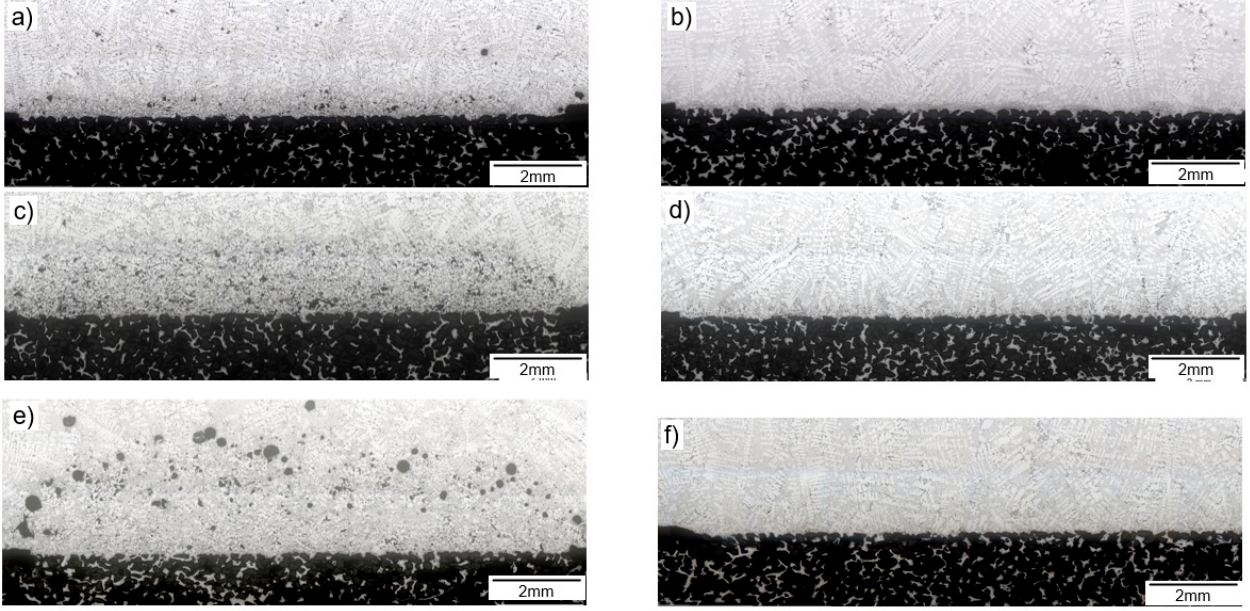
Figure 6. The inclusion cakes used for the different alloys: ( a ) before and ( b ) after the melt treatment for the primary alloy sample; ( c ) before and ( d ) after the melt treatment for the secondary alloy sample made from ingots; ( e ) before and ( f ) after the melt treatment for the secondary alloy sample made from new scrap. Table 5. Thicknesses of the inclusion cakes.